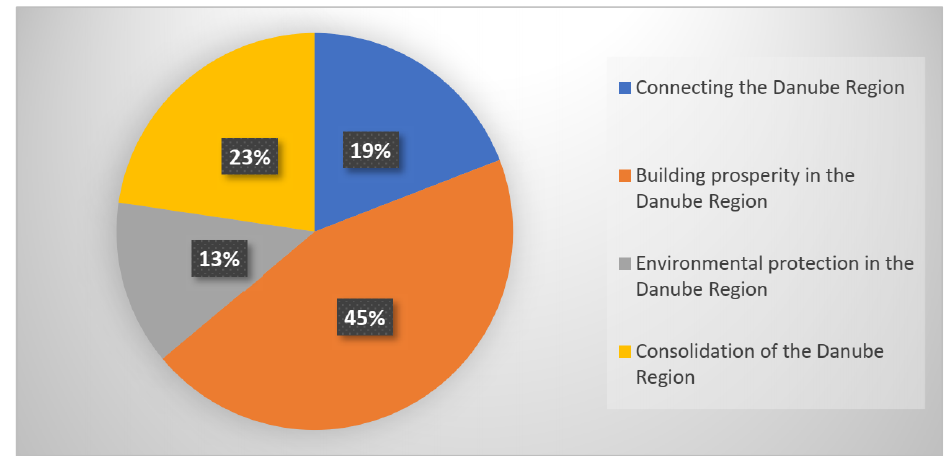
Figure 2. Major directions of intervention in the Danube